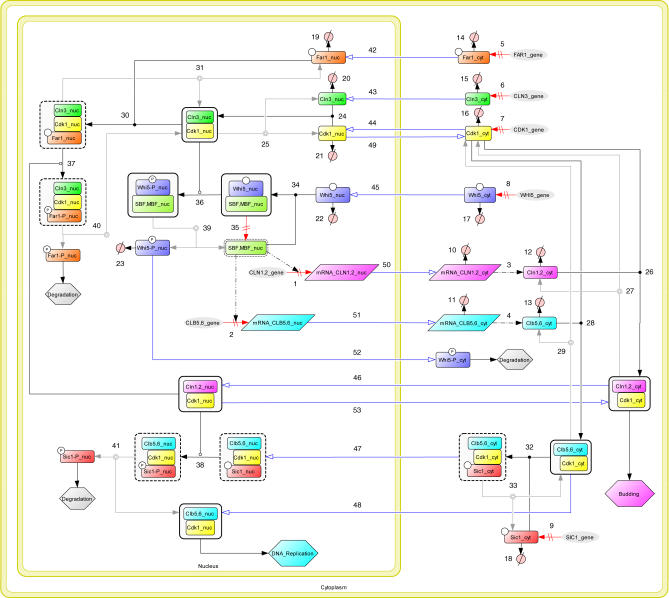
Processes Regulating the G1/S Transition in Yeast Cell CycleThe model comprises transcription of genes coding for cyclins (reactions 1–2), mRNA translation for cyclins, Cdk1, and Ckis (3–9), degradation of mRNA (10–11) and proteins (12–23), reversible or irreversible formation of binary (24–29) and ternary (30–34) protein complexes, Cln3-independent formation of SBF/MBF (35), phosphorylation of protein complexes (36–38), and dissociation of phosphorylated protein complexes (39–41) followed by degradation of the phosphorylated protein. Transport of proteins and protein complexes occurs from cytoplasm to nucleus (42–48) and vice versa (49–53).